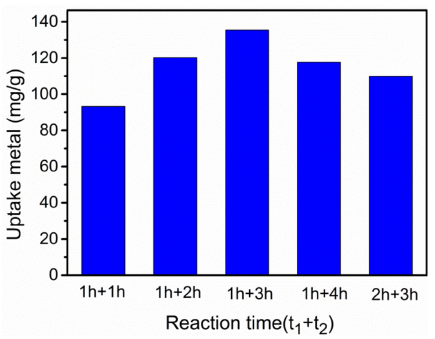
Figure 3. Effect of the grafting reaction times on Pb(II) removal and q e . (Reaction conditions: C i = 400 mg · L − 1 , pH = 8, T = 50 ◦